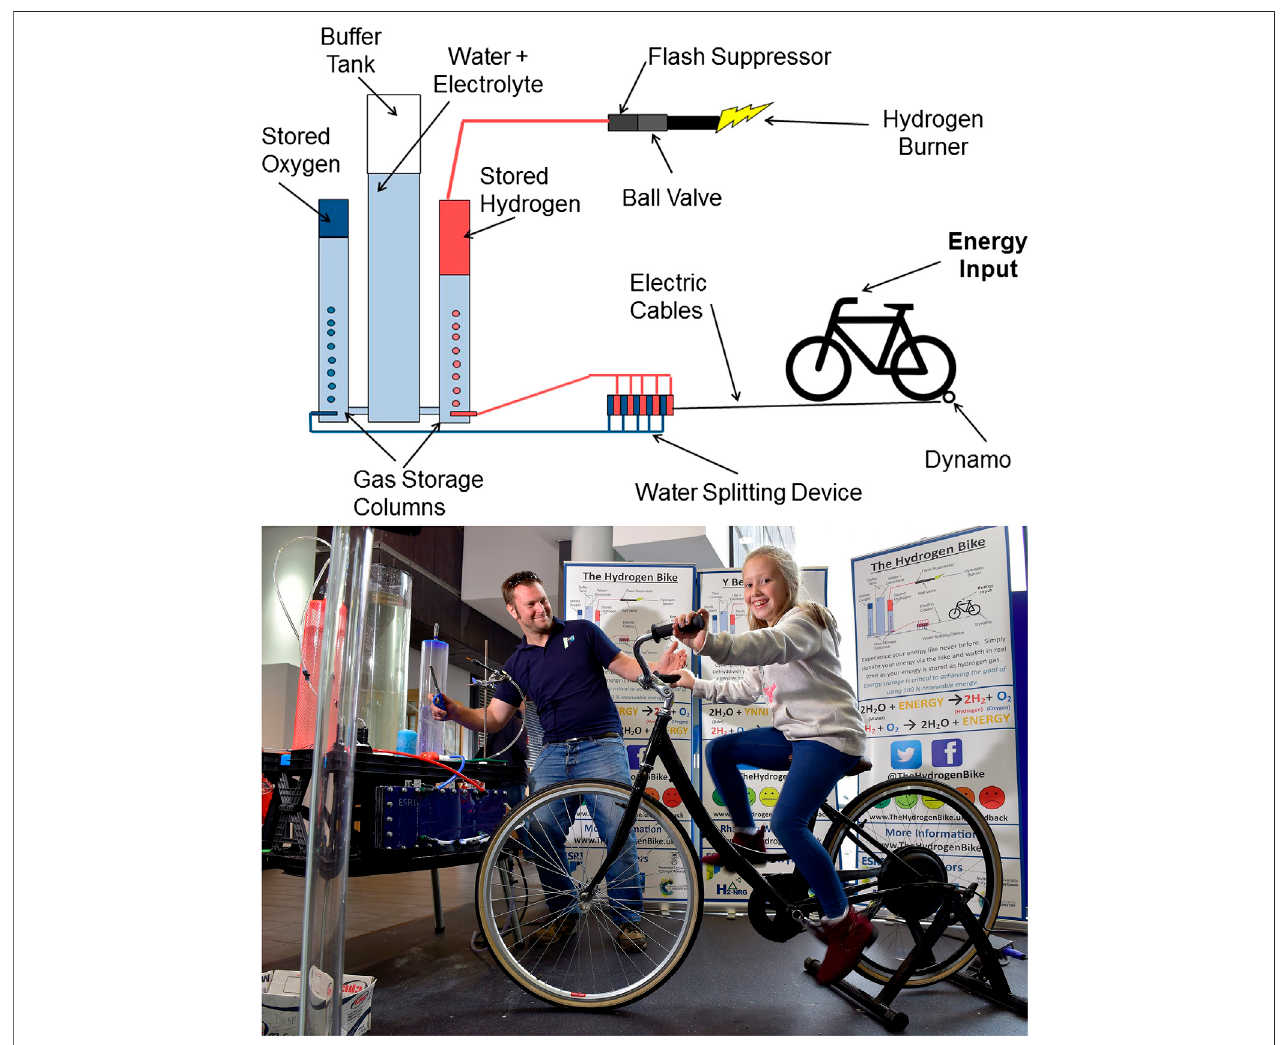
FIGURE 1 | (A) . Schematic of The Hydrogen Bike exhibit, depicting the alkaline electrolysis cell powered by a dynamo built into the rear wheel of the stationary bicycle. Also shown are the hydrogen and oxygen gas collection containers and the central “ buffer tank ” into which aqueous sodium bicarbonate electrolyte is forced during gascollection.During thedemonstration, stored hydrogenis continuously used by ahydrogen fuelcell to power LEDs beneath each ofthe gasstorage columns, and the gas is also admitted to a burner to demonstrate a stable hydrogen fl ame. (B) . Photo of a participant on The Hydrogen Bike .